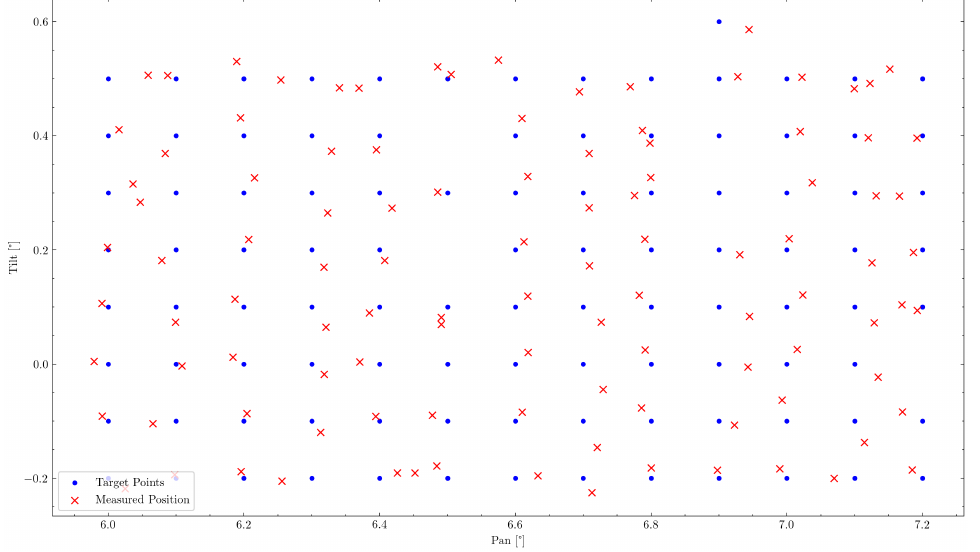
Figure 14. RMSE evaluation of the DJI